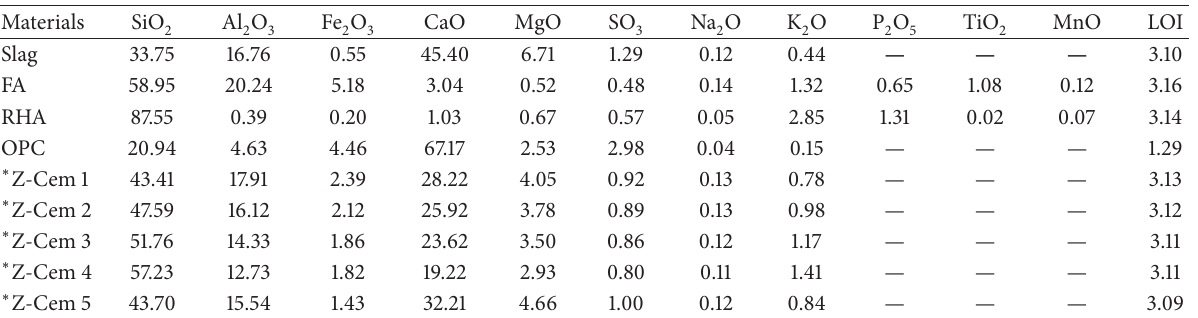
Table 2: Chemical and physical properties of the materials